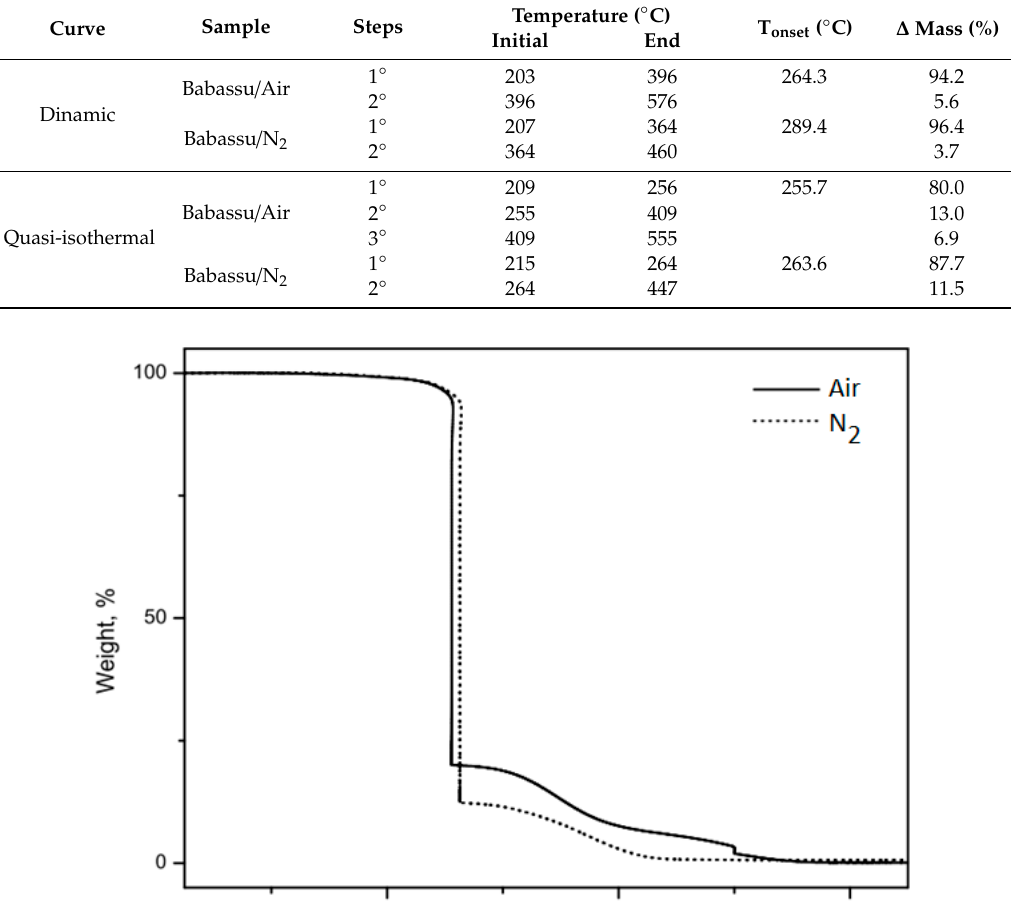
Table 3. Results obtained from the TG / DTG curve of babassu oil in a synthetic air (Air) and nitrogen (N 2 ) atmosphere under dynamic and almost isothermal conditions.